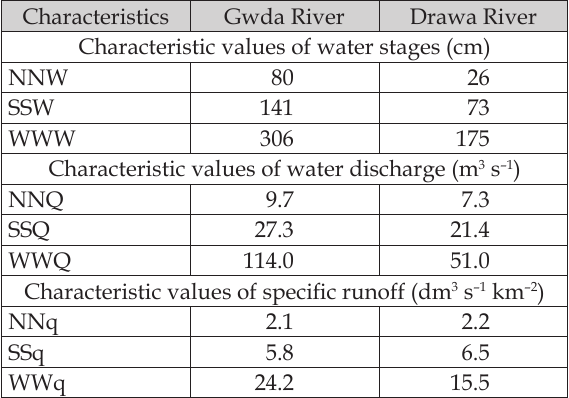
Table 2. Hydrological characteristics of the Gwda and Drawa River in